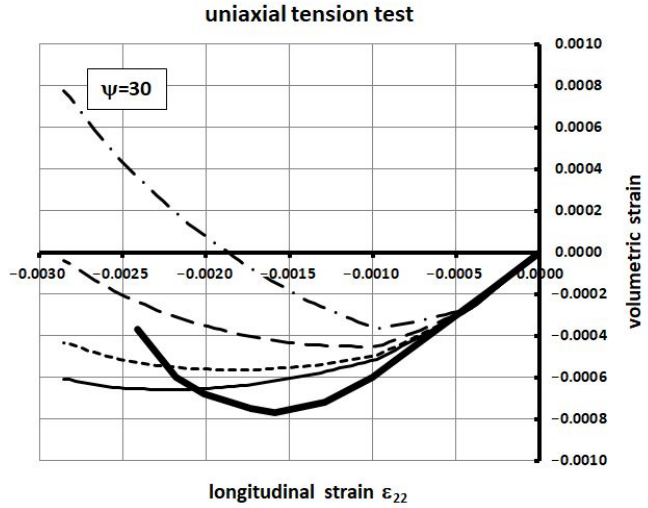
Figure 5. Volumetric strain vs. longitudinal strain for different dilatation angle values in the uniaxial compression test.